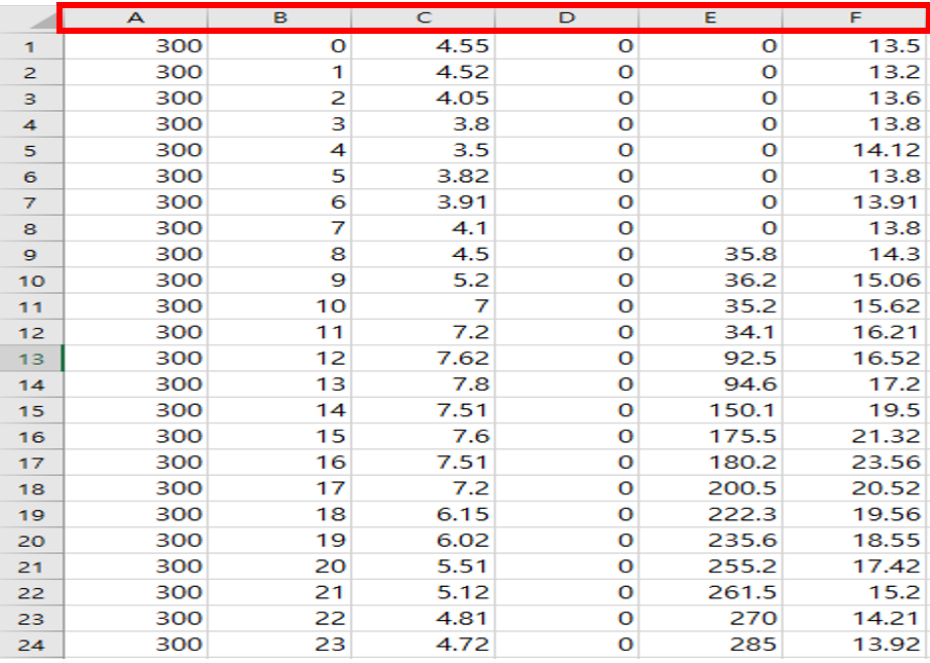
Figure 13. Configured training dataset for detecting malfunctions in ventilation devices using the recurrent neural network model.